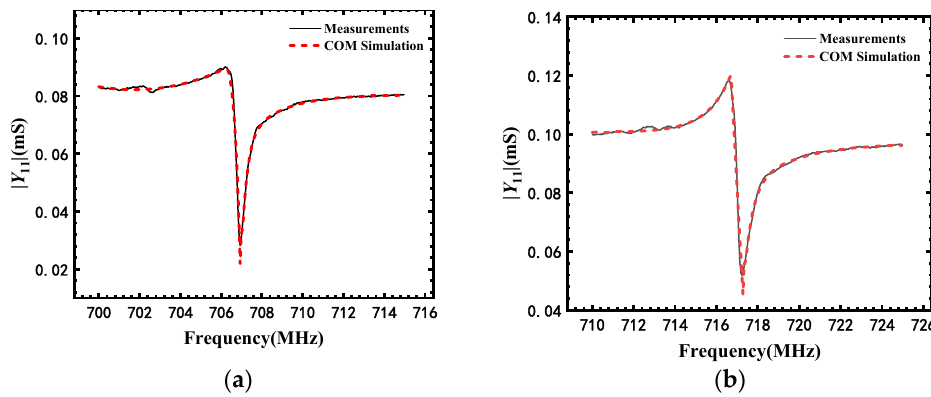
Figure 9. Admittance extracted from the COM simulation compared with the experimental results of